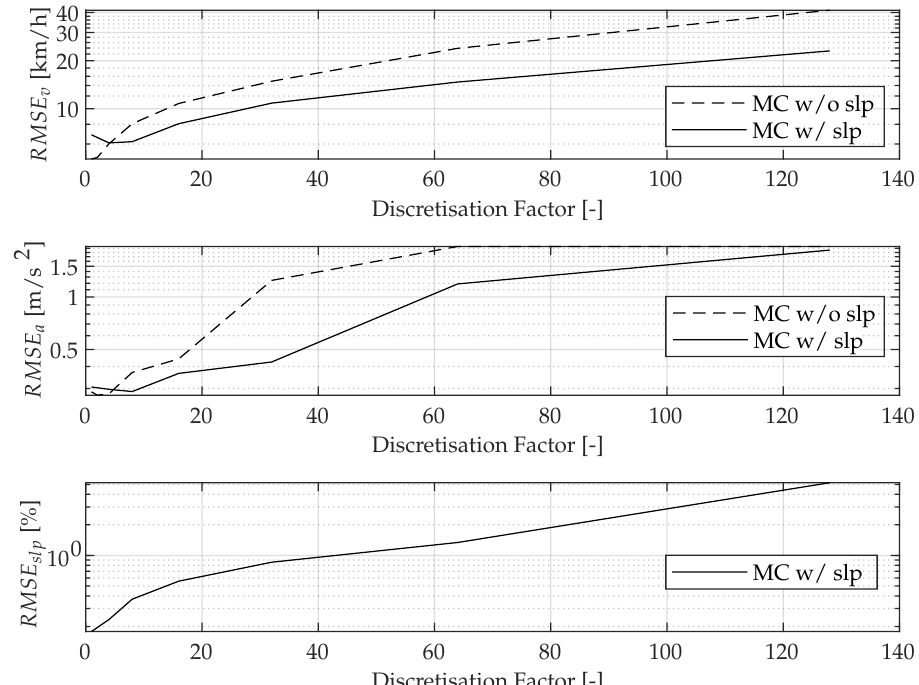
Figure 7. Parameter study: RMSE as a function of the discretisation of the Markov states.